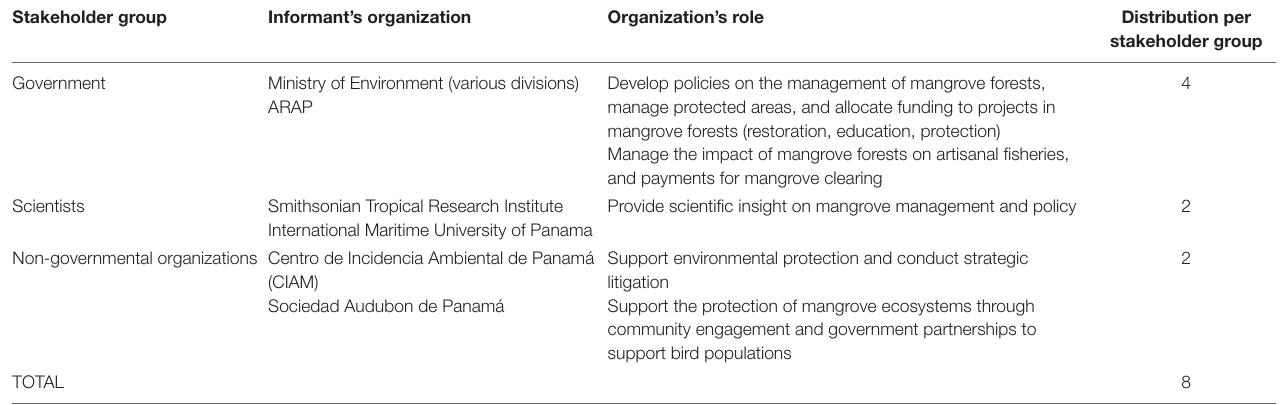
TABLE 1 | Overview of interviewed